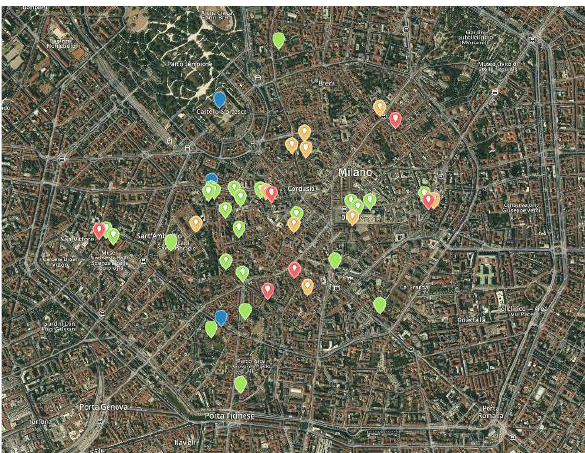
Figure 1. Location of the archaeological sites object of the Mediolanum MMXV project research. In green the accessible sites, in yellow the sites accessible on request, in red the sites not accessible to the public, in blue the main archaeological